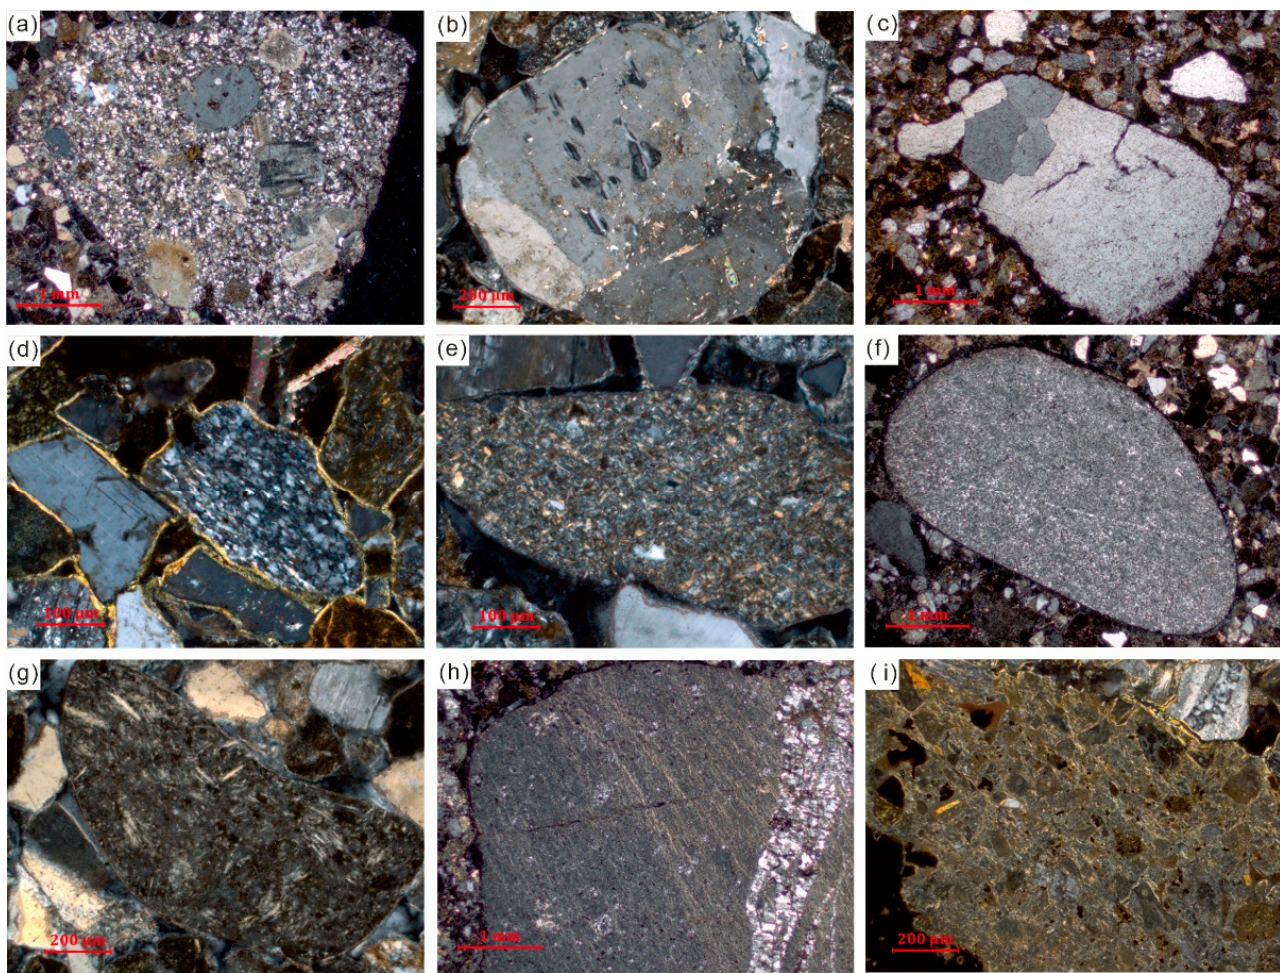
Figure 3. Lithic fragments of mineralized sandstones in the Kamust uranium deposit. ( a ) Granite–porphyry fragments with porphyritic structure. Phenocrysts are quartz and feldspar, and the matrix is a fully crystalline structure. ( b ) Granite fragments composed of quartz and feldspar. ( c ) Polycrystalline quartz. ( d ) Quartz schist fragments with a small amount of sericite and flake structure, and potassium feldspar fragments on the left. ( e ) Metamorphic siltstone fragments. ( f ) Siliceous gravel composed of microcrystalline quartz. ( g ) Andesite fragments with interlaced structure. ( h ) Rhyolite fragments with faintly visible flow structure, and the matrix is a fine structure interspersed with quartz veins. ( i ) Pyroclastic fragments, containing a large number of crystal pyroclasts.